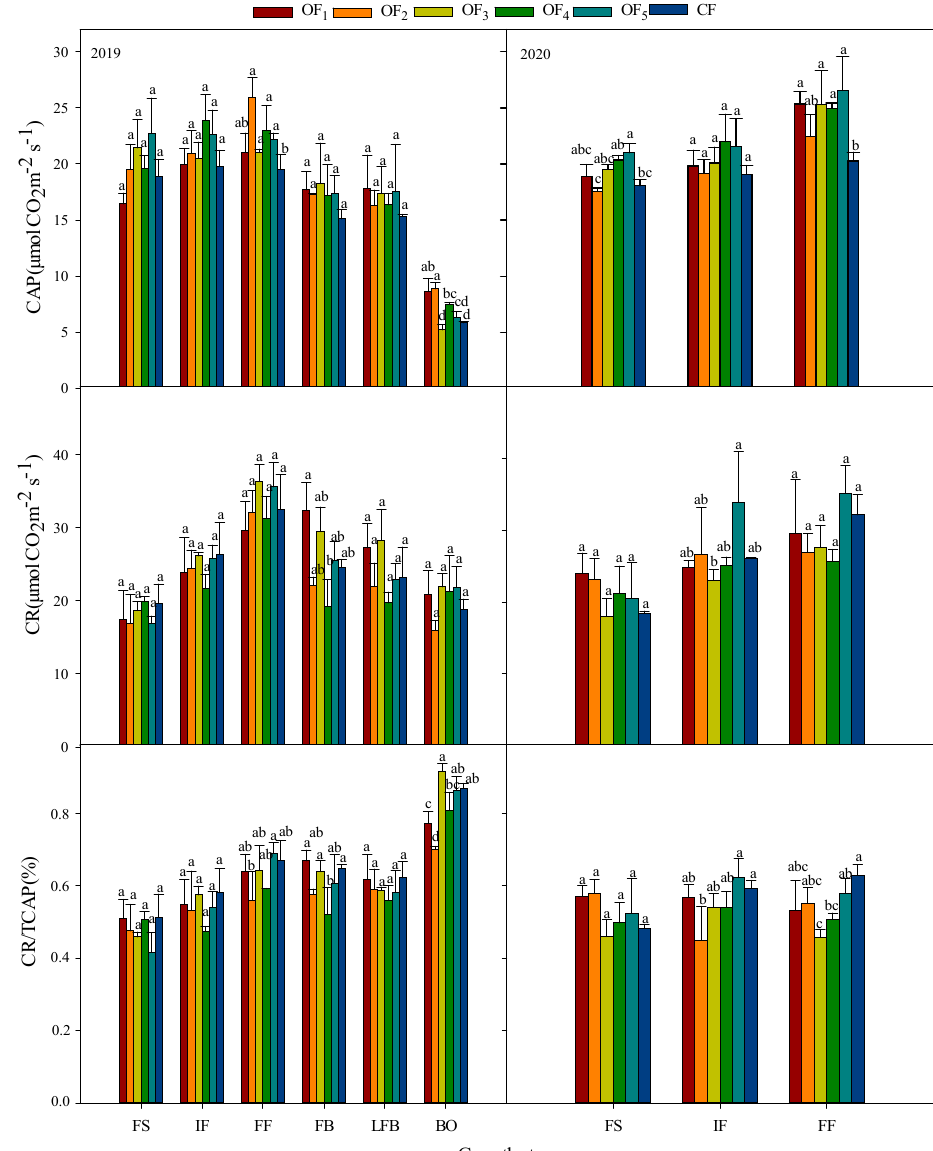
Figure 7. Effect of organic liquid fertilizer combined with different ratios of chemical fertilizers in cotton populations. FS, full-squaring stage; IF, initial flowering stage; FF, full-flowering stage; FB, full-boll stage; LFB, late full-boll stage; BO, boll-opening stage. Different letters above the columns indicate statistical significance at the p = 0.05 level within the same growth stage in each